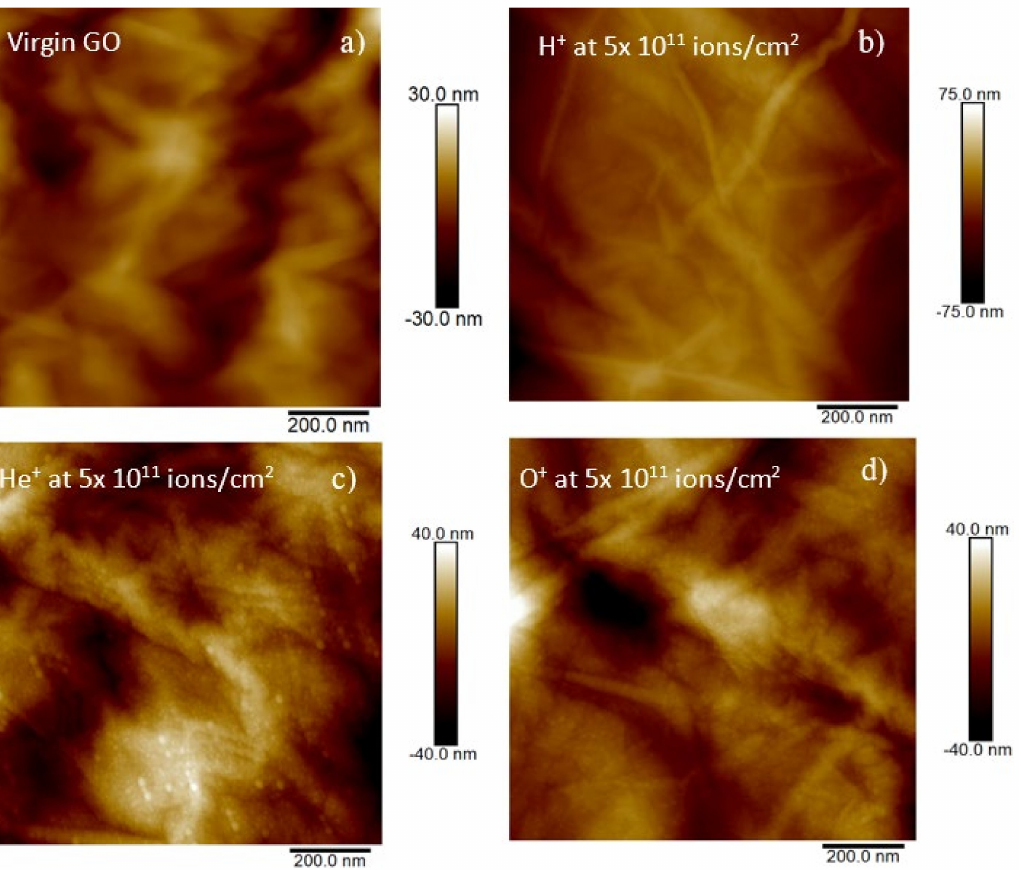
Figure 4. 2D AFM images (scan area of 1 × 1 µ m) in the virgin GO ( a ), GO irradiated by H + at 5 × 10 11 ions/cm 2 ( b ), GO irradiated by He + at 5 × 10 11 ions/cm 2 and ( c ), GO irradiated by H + at 5 × 10 11 ions/cm 2 ( d